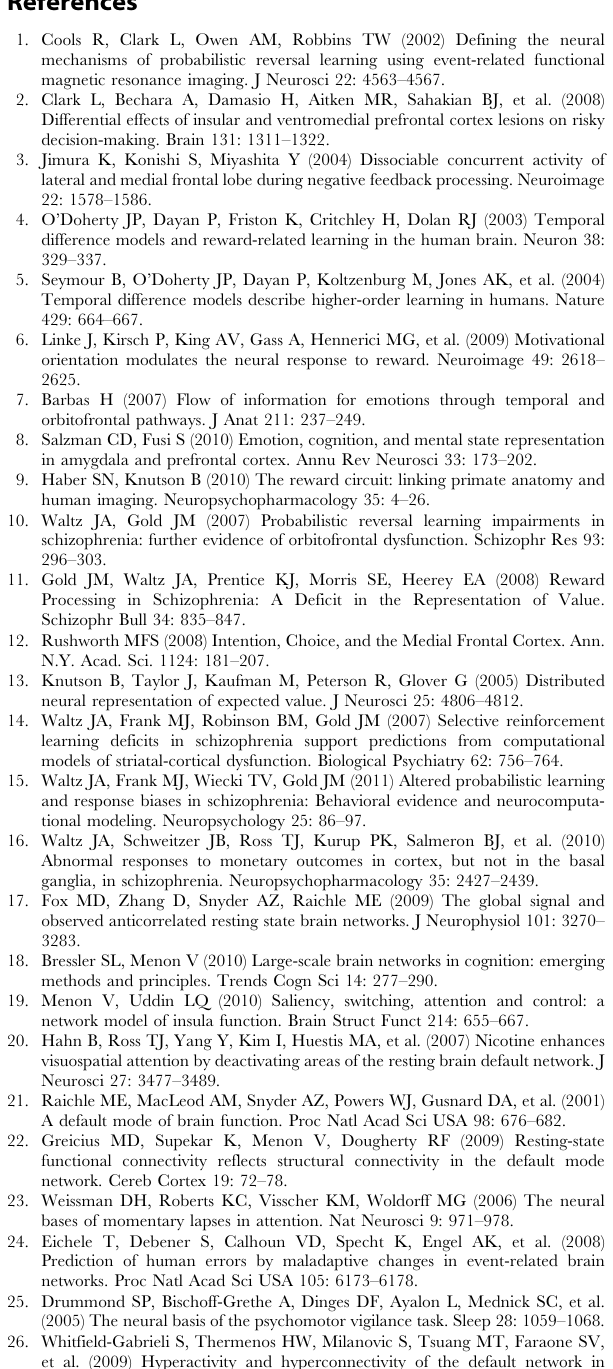
Table S8 Correlations between haloperidol-equivalent antipsy- chotic dose and behavior ([Lose-stay-Lose-shift]) contrasts in Network Components. No significant correlations were observed among antipsychotic doses and shift-evoked neural activity in DMN nodes or ECN